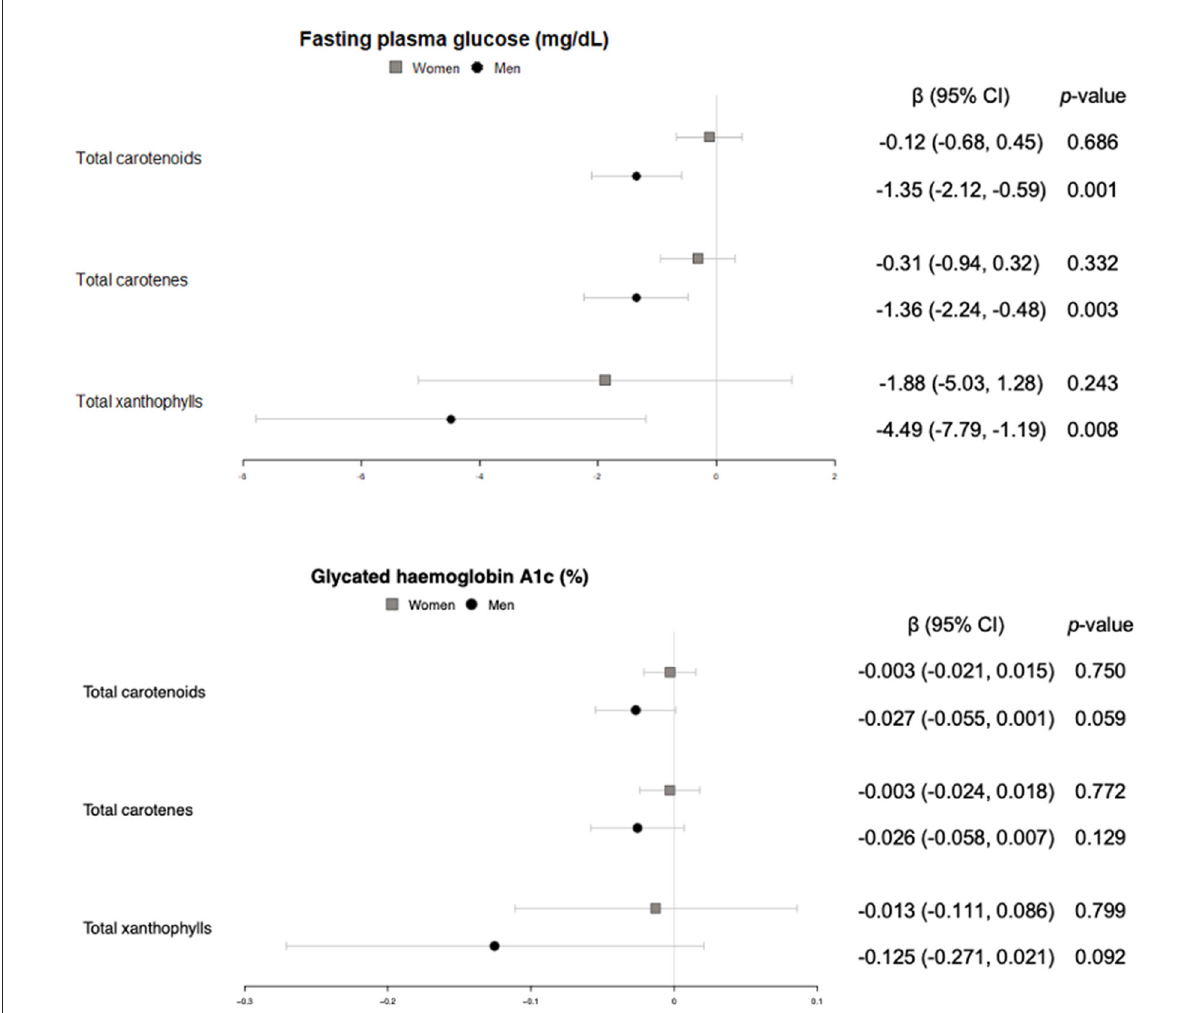
FIGURE5 Cross-sectional association of plasma carotenoids and subclasses (per unit increase) with fasting plasma glucose (mg/dl) and glycated hemoglobin A1c (%) (95%-CI), and their respective p